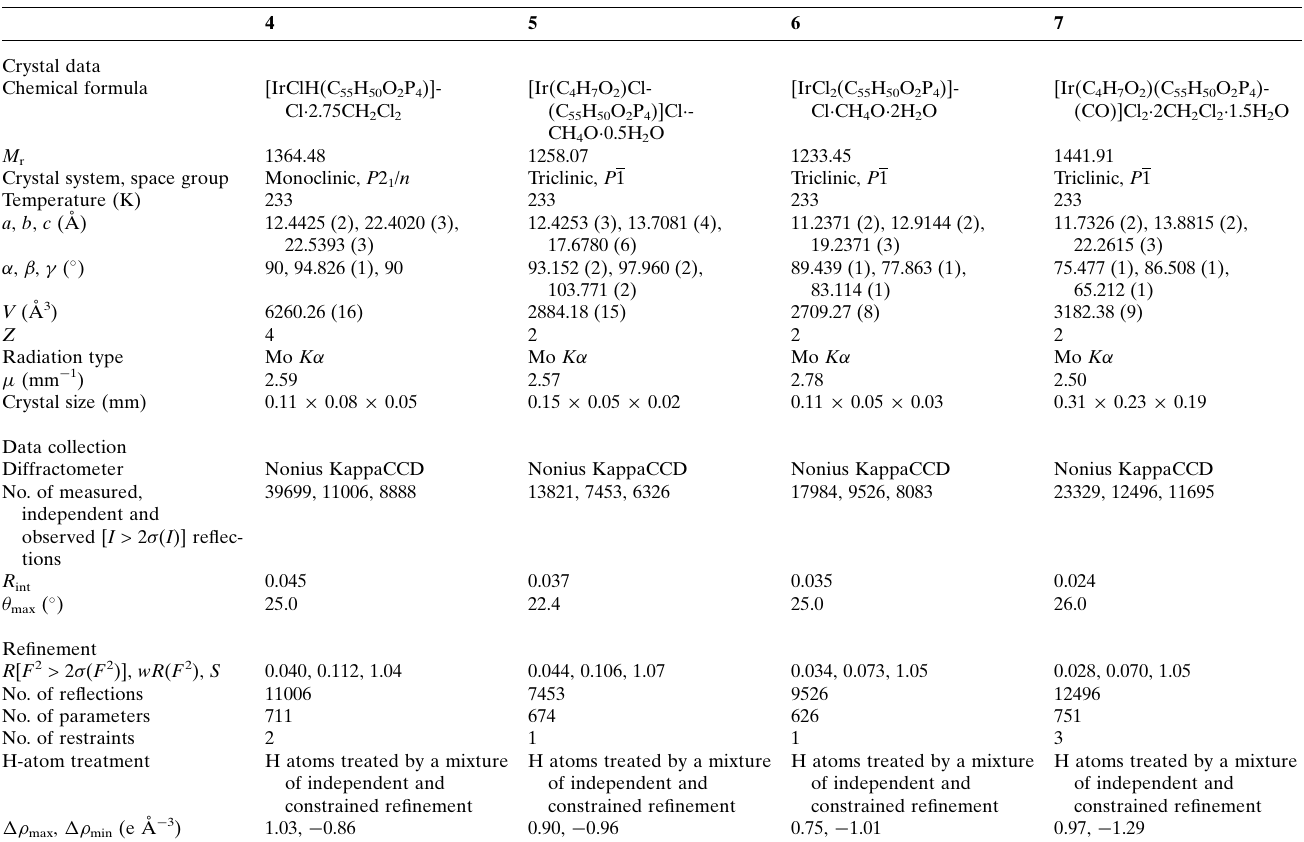
Table 6 Experimental details.